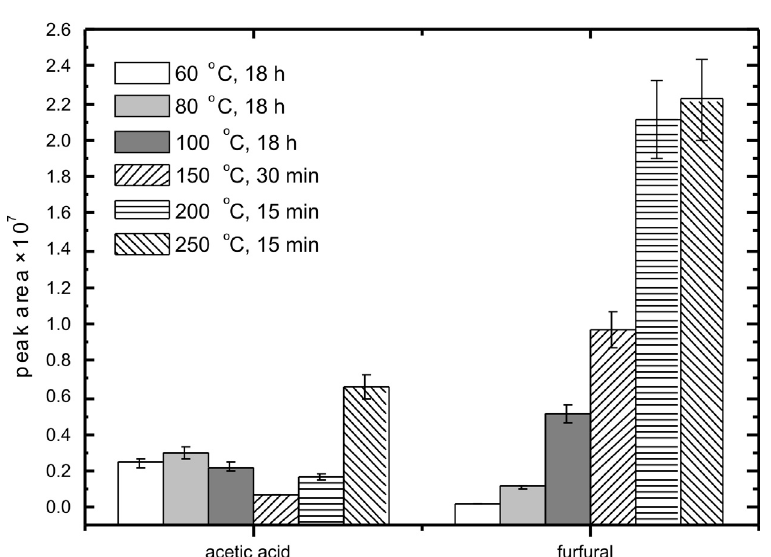
Figure 2. Comparison of chromatographic peak areas for acetic acid and furfural emitted by sample no. 14 in a glass vial at different conditions. Conditions of extraction using SPME fibre: 40 o C, 1 h. The intervals denote standard deviation of triplicate